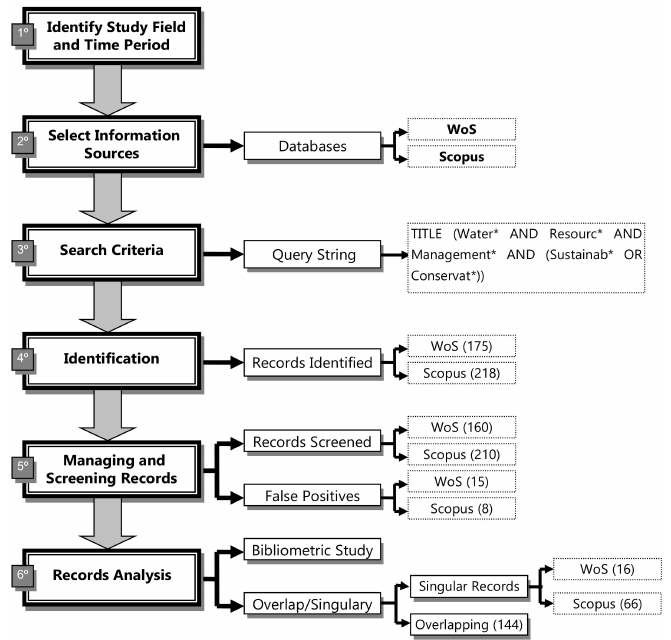
Figure 2. Bibliometric Methodological Procedure. Source: The authors’ own elaboration.